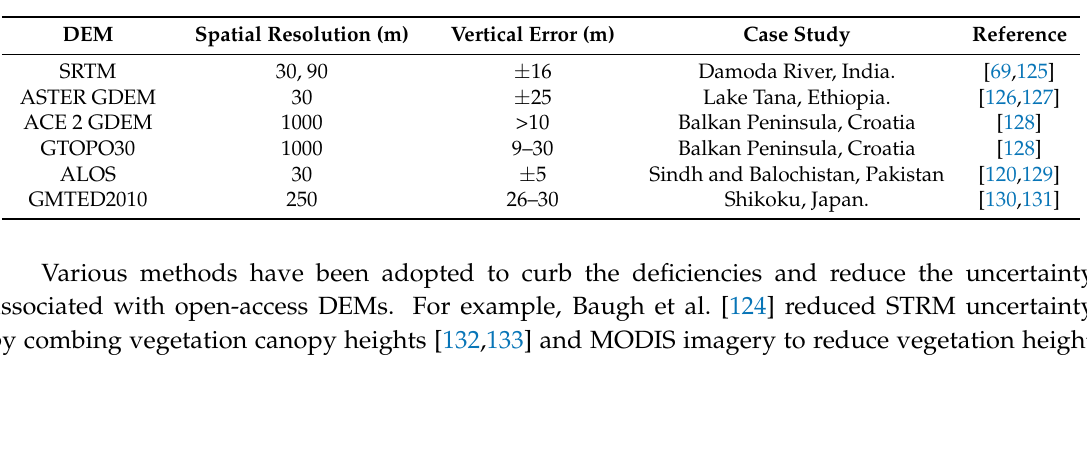
Table 3. Open source digital elevation models properties and case